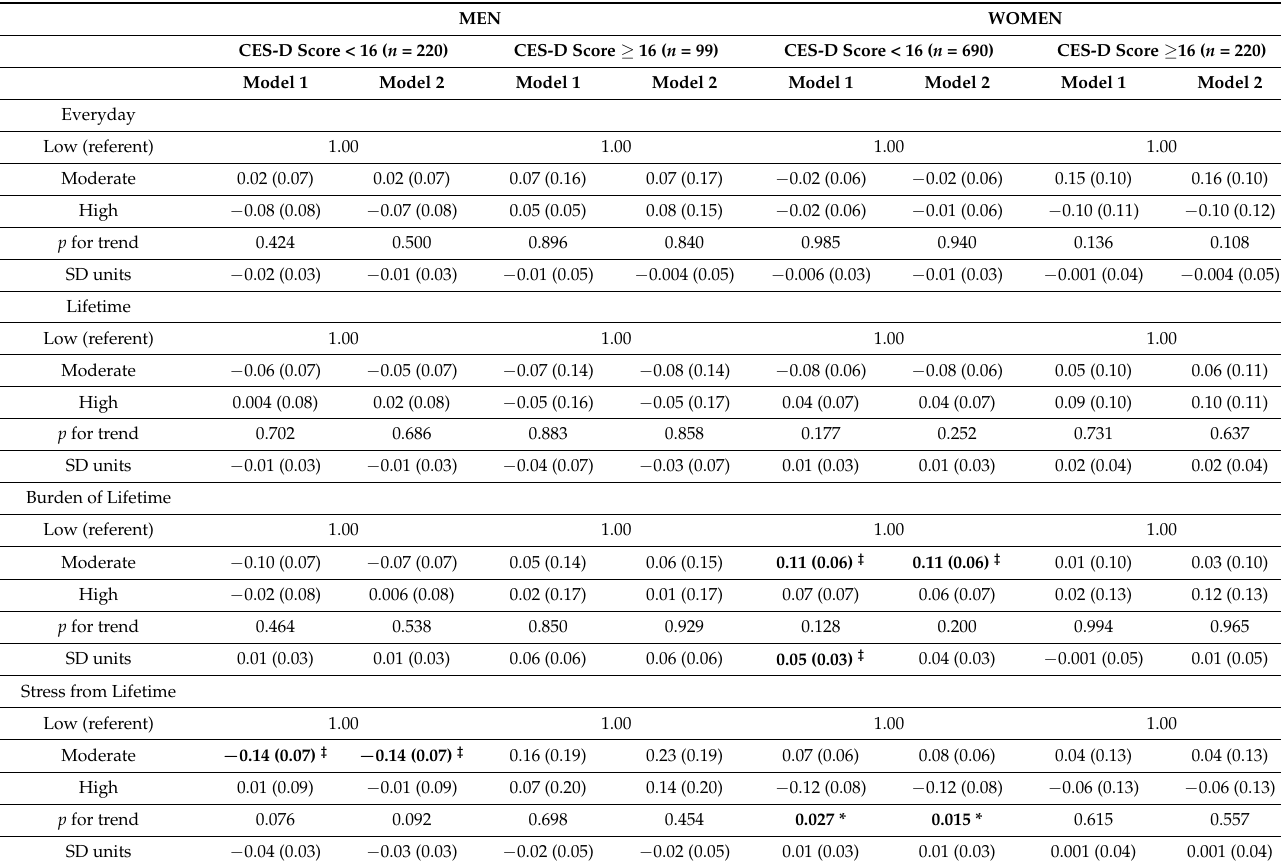
Table 2. Mean difference (standard errors) in leukocyte telomere length by perceived discrimination and depressive symptoms among men and women, Jackson Heart Study